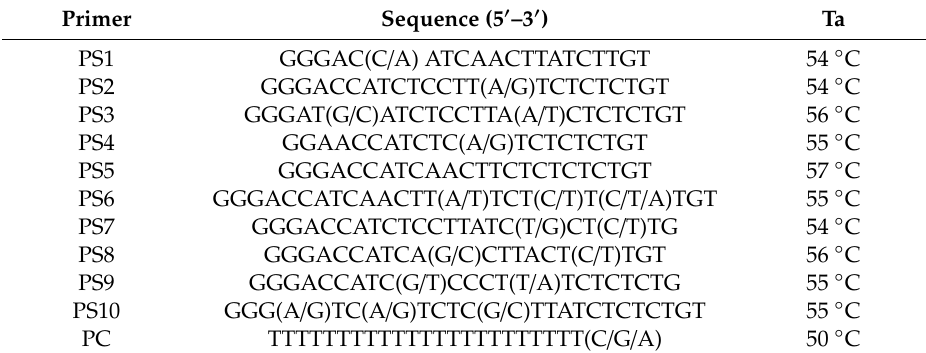
Table 1. Primer sequences used for antimicrobial peptides’ (AMPs’) amplification.